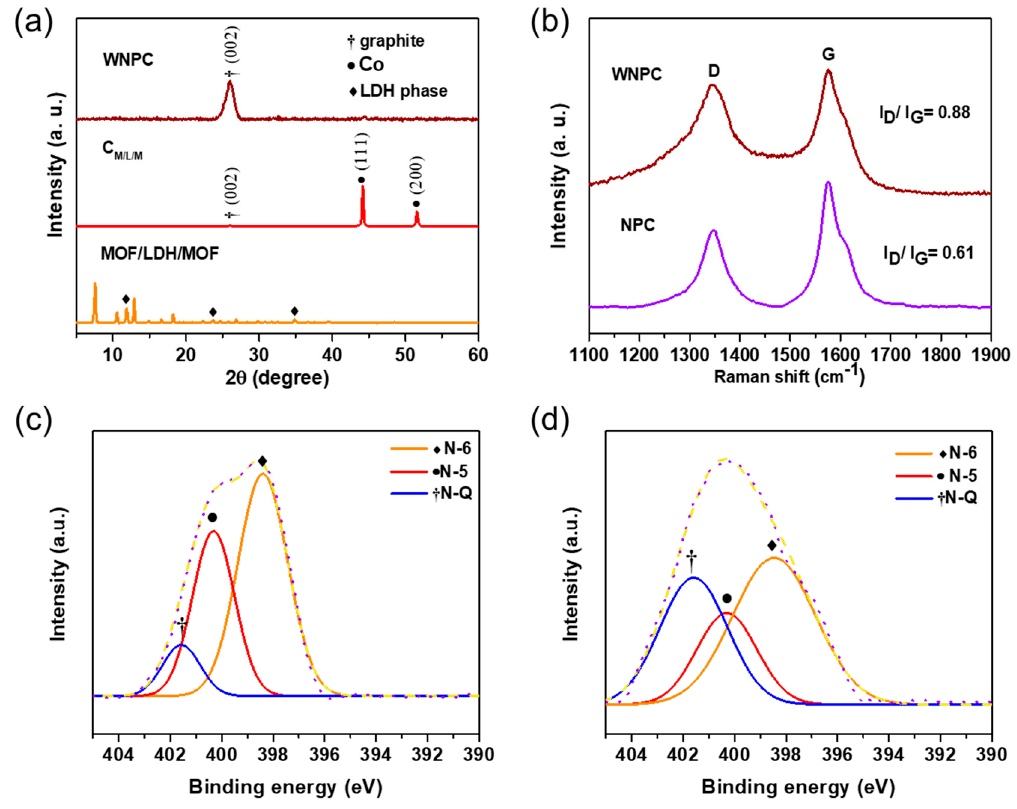
Figure 3. ( a ) XRD pattern of MOF/LDH/MOF, C M/L/M , and WNPC; ( b ) Raman spectrum of WNPC and NPC. High-resolution XPS spectra for N1s of ( c ) WNPC and ( d ) NPC. Table 1. Elemental analysis results for NPC, WNPC and the carbonized sample of the mixture of Co- MOF and CoAl-LDH.